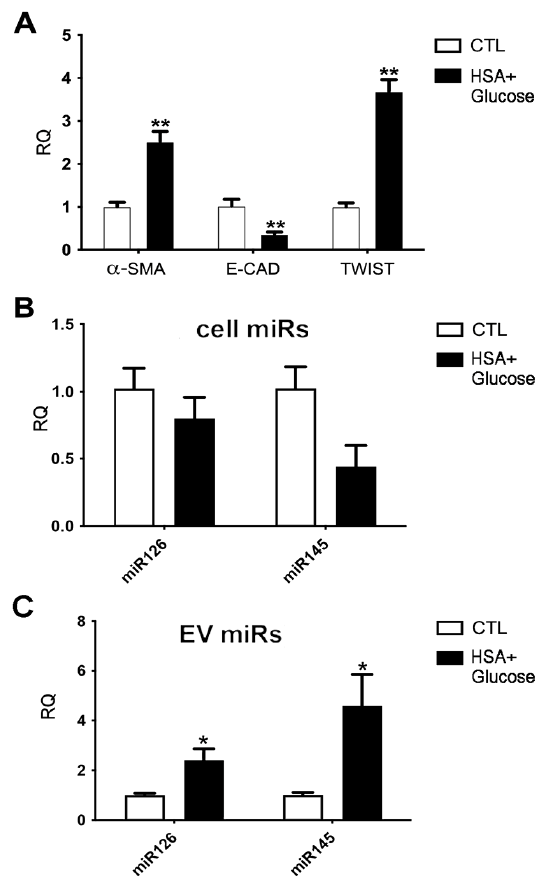
Figure 4. ( A ) Relative quantification of EMT genes α -SMA, E-cadherin and TWIST in human prox- imal tubular cells (HK2) treated with 10 mg/mL of HSA and 30 mM Glucose. ( B , C ) MiR126 and miR145 levels were evaluated in HK2 in diabetic-like conditions ( B ) and in their released EVs ( C ) Untreated HK2 and their released EVs were used as control (CTL) (n = three independent experiments). (* p < 0.05: ** p < 0.001 vs. CTL).